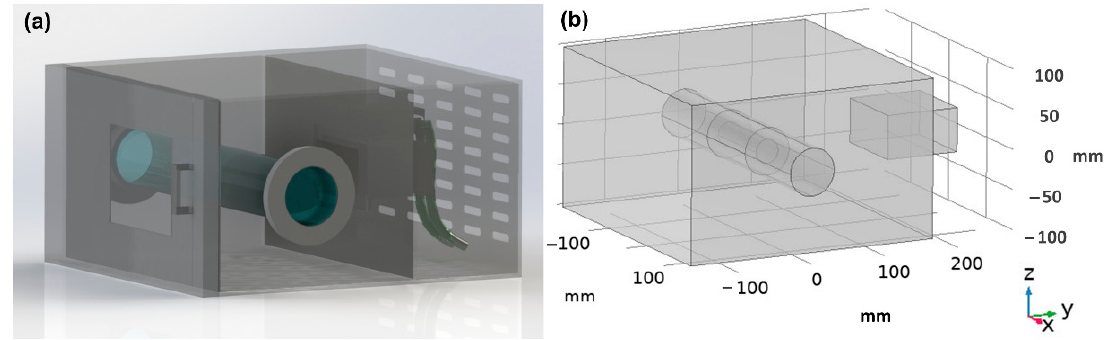
Figure 2. Structure of the microwave reactor for ex situ biomass tar elimination: ( a ) structural model; and ( b ) simulation model of the resonant cavity.